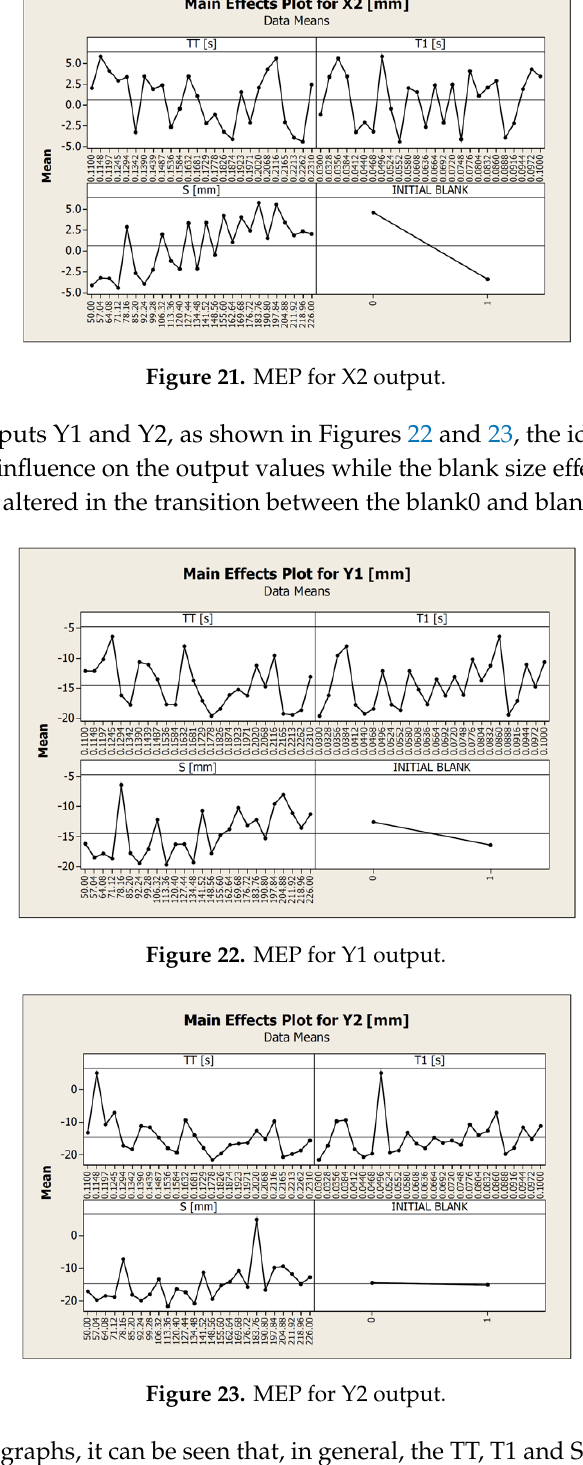
Figure 20. MEP for X1 output.